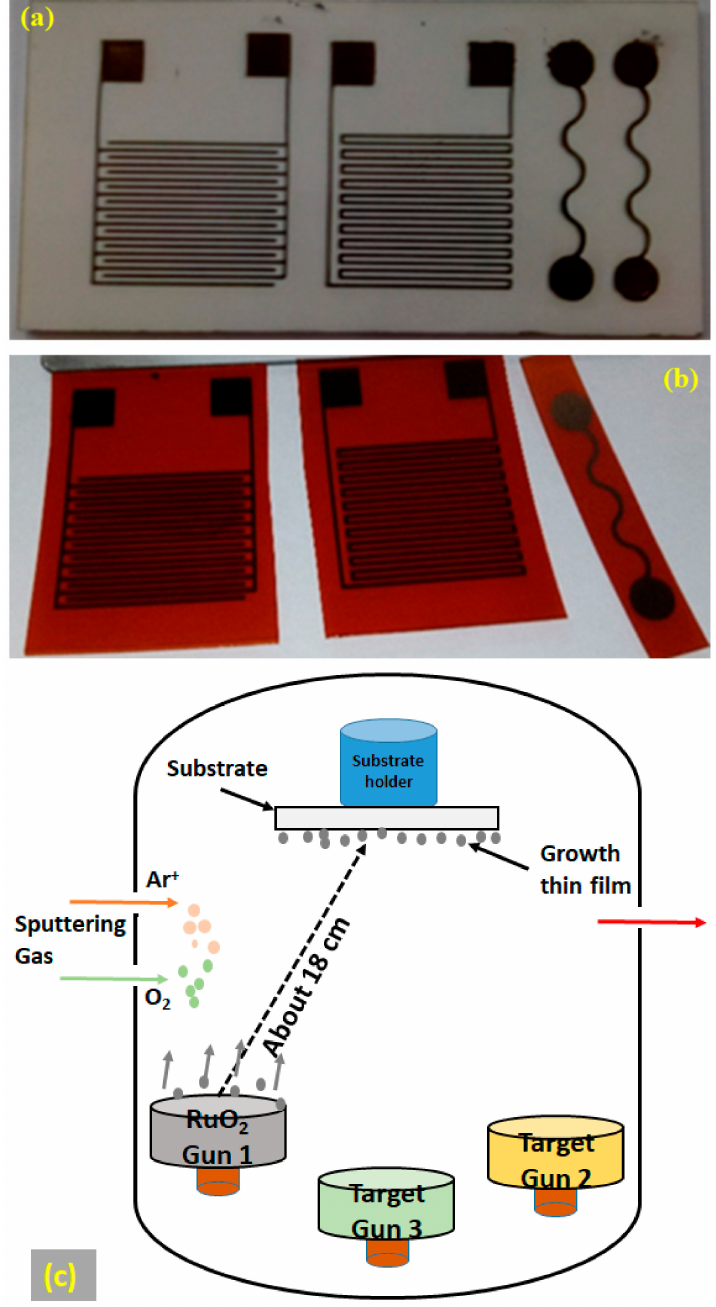
Figure 5. Potentiometric, interdigitated, and resistive RuO2 electrodes, 100 nm thick, sputter-deposited on ( a ) Alumina; ( b ) Polyimide substrates; and ( c ) schematic diagram of the up-sputtering system